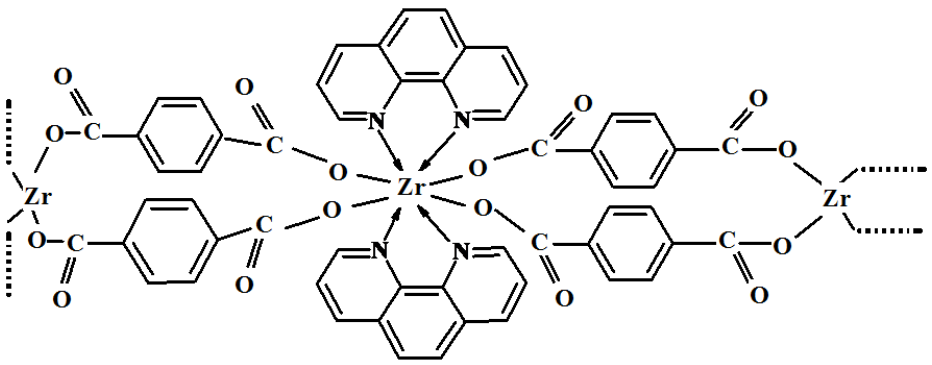
Figure 2. Plausible structure of the sorbent.